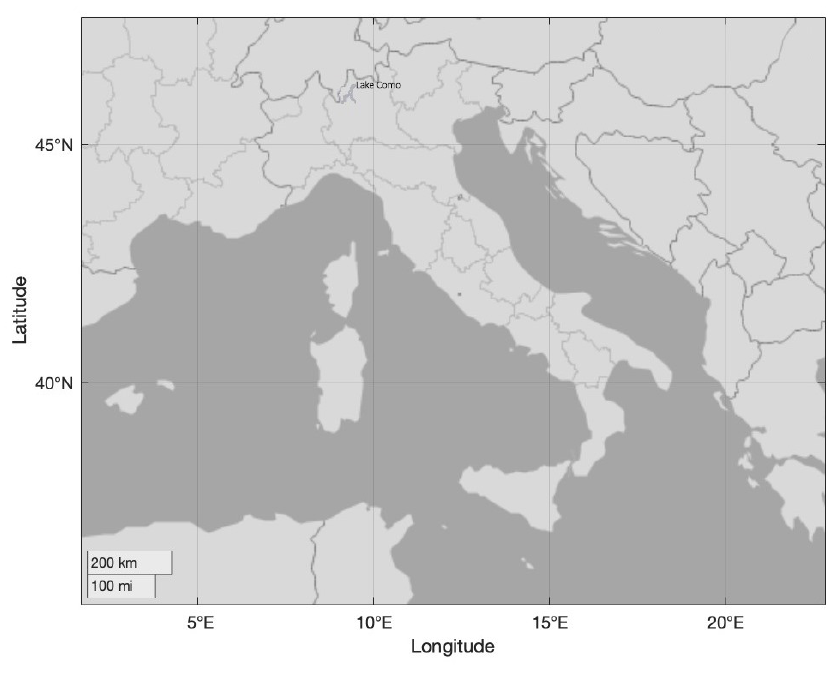
Figure 1. Lake Como